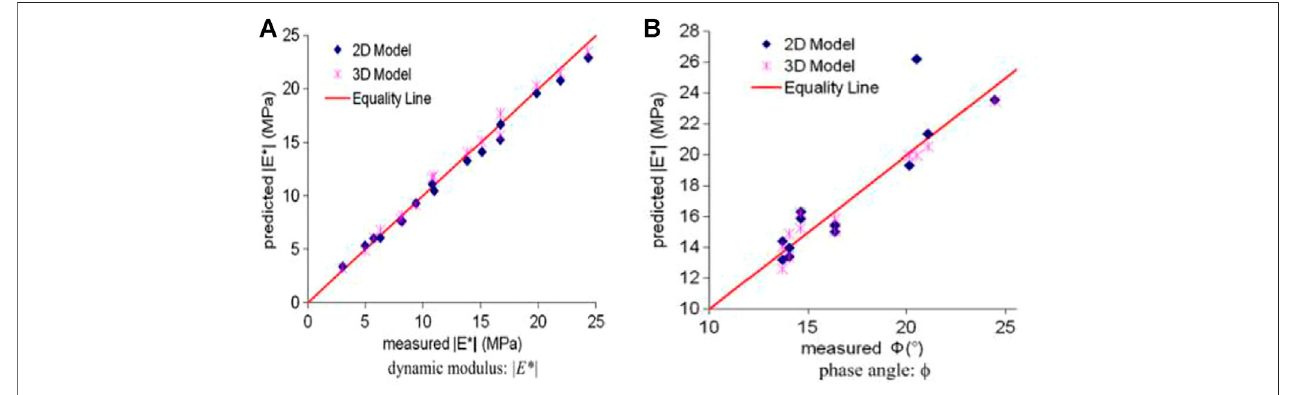
FIGURE 5 | Fitting curves between the simulation data and measured values in the laboratory with the 2D and 3D DEMs, (A) the dynamic modulus; (B) the phase angle (Liu and You, 2011b).